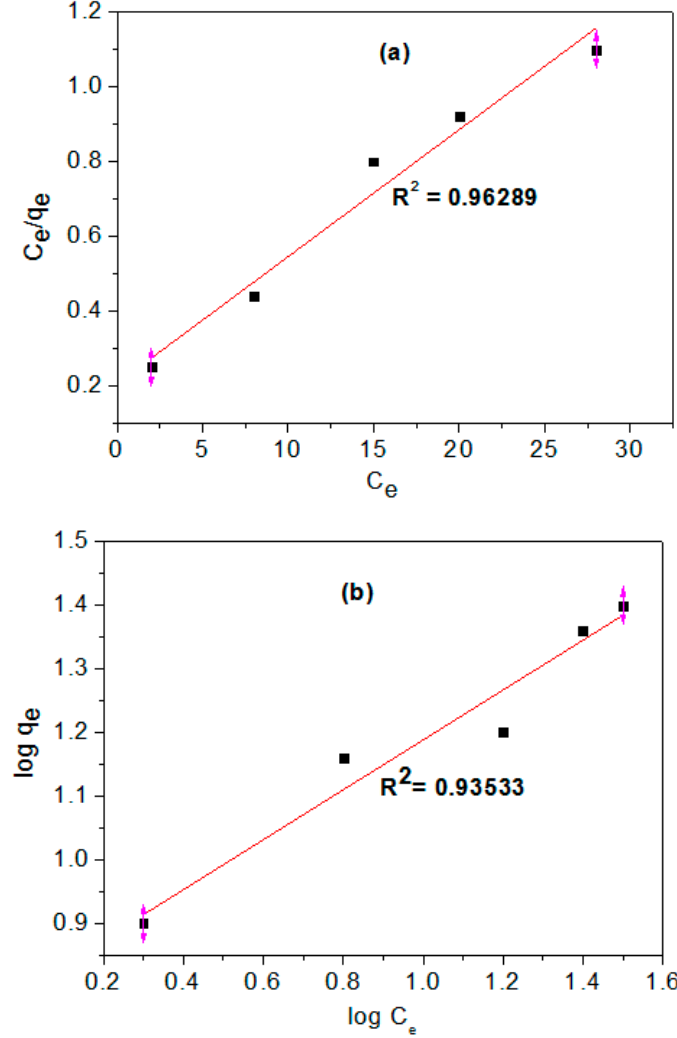
Figure 5. ( a ) Langmuir and ( b ) Freundlich equilibrium isotherms of MB sorption onto optimum